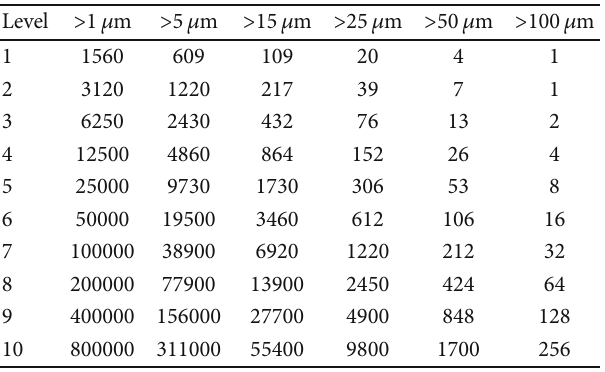
Table 2: The contamination degree data (particle number per 100mL) of GJB420B.